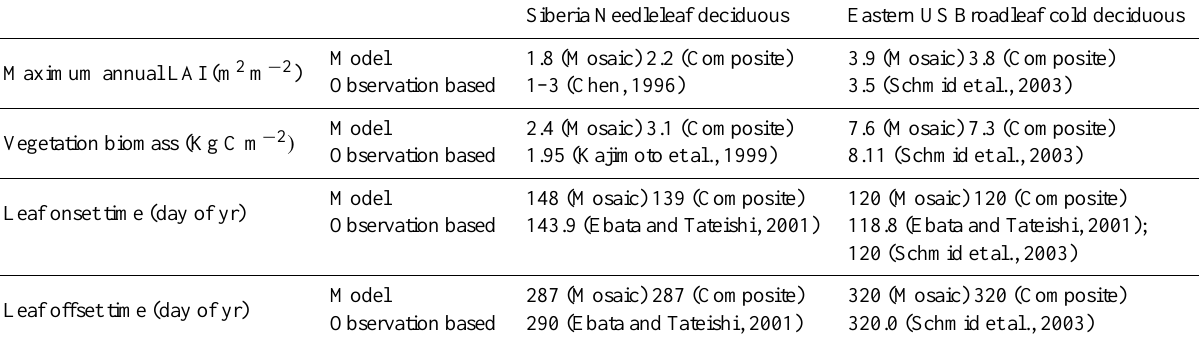
Table 4. Comparison of simulated maximum annual LAI, vegetation biomass, and leaf onset and offset times with observation-based estimates for the Siberia and Eastern US locations. Simulated values are shown for both the composite and mosaic